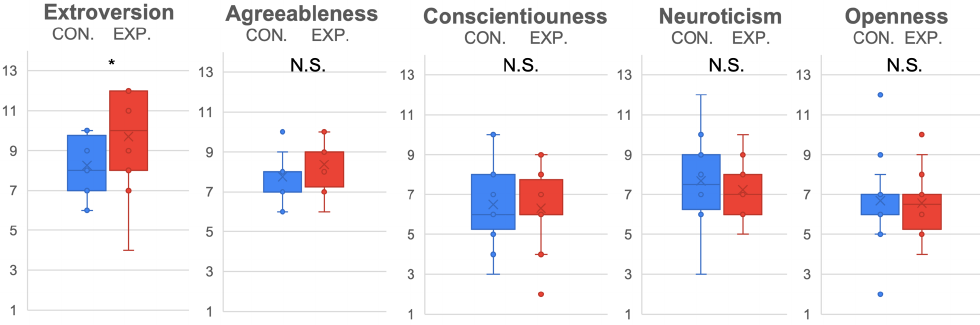
Figure 7. Personality evaluation of ERICA with Big Five by all subjects. * indicates the found significant difference, while N.S. indicates there is no significant difference.